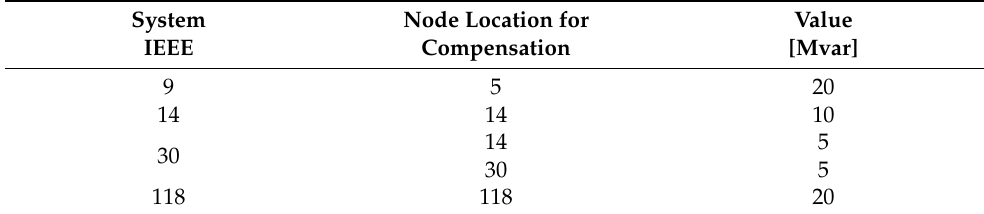
Table 2. Reactive compensation values